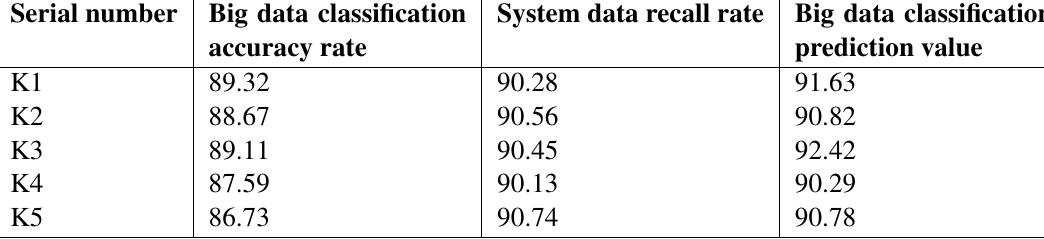
Table 1 Big data classification processing results based on Web data system.